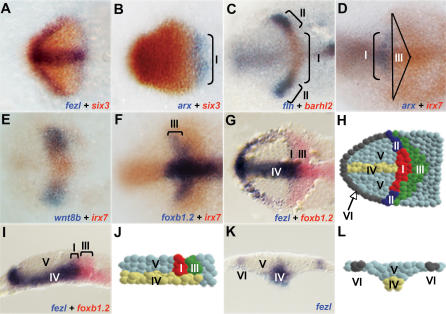
Expression Profile of the Rostral Neural Plate(A–G) Rostral neural plate, anterior to the left. Embryos at bud stage (A–D, F, G , I, and K) or 100% epiboly (E) are shown.(A) six3 (red), fezl (blue). (B) six3 (red), arx (blue). (C) barhl2 (red), flh (blue). (D) irx7 (red), arx (blue). (E) irx7 (red), wnt8b (blue). (F) irx7 (red), foxb1.2 (blue). (G) foxb1.2 (red), fezl (blue). (H) Scheme of the different expression domains inside the diencephalon anlage shown in (A–G). (I) Sagittal section, anterior left, foxb1.2 (red), fezl (blue). (J) Scheme of (I). (K) Transverse section, fezl (blue). (L) Scheme of (K). The different domains are the presumptive anteromedial (I), anterolateral (II), and posterior (III) diencephalon, hypothalamus (IV), and eye field (V).